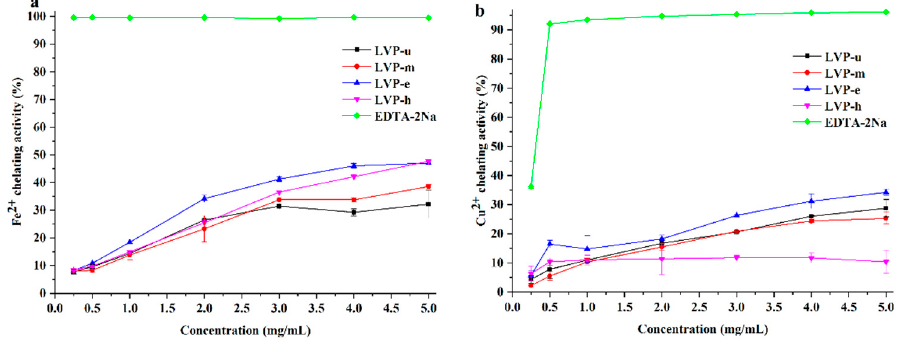
Figure 7. Metal ions chelating abilities of LVPs extracted by di ff erent methods. ( a ) Fe 2 + chelating ability; ( b ) Cu 2 + chelating